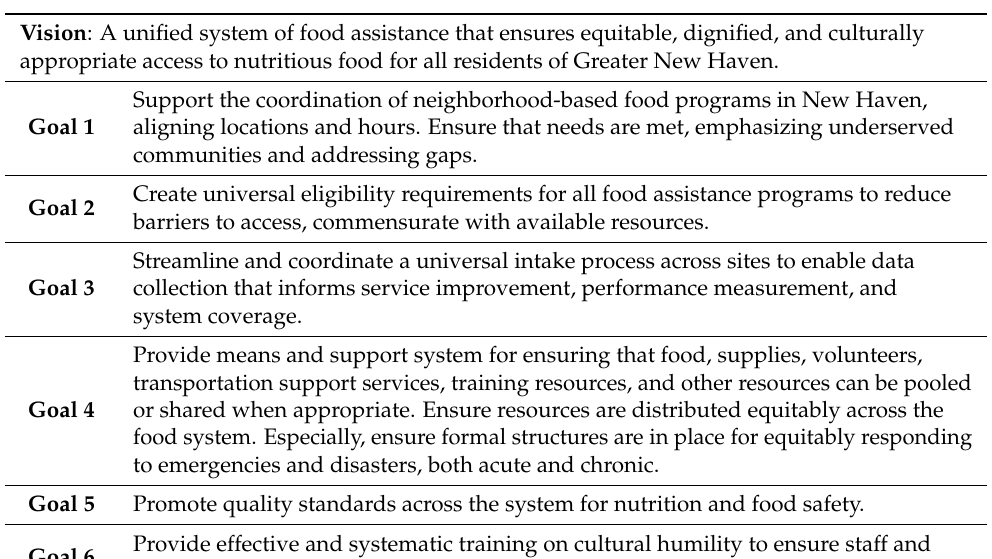
Table 2. Coordinated Food Assistance Network: Vision and Goals, updated May 2020